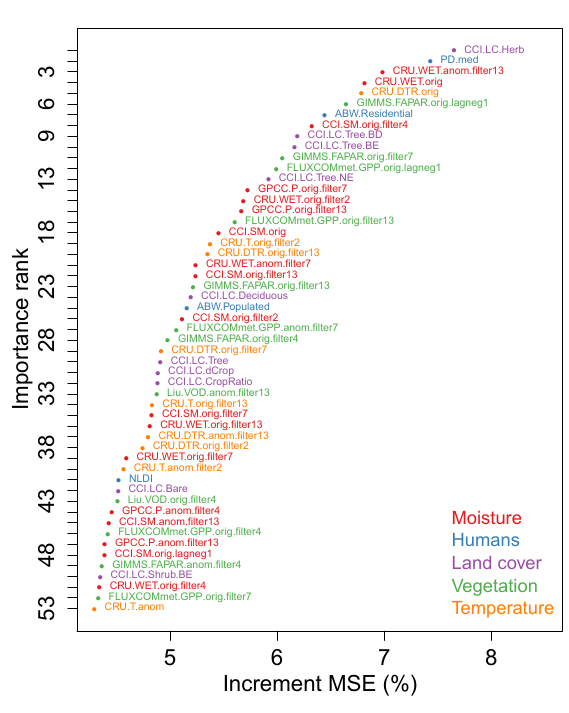
Figure A1. Importance of several predictor variables for predicting monthly burned area using a random forest. Importance is expressed as the percentage increment in mean squared error if a certain vari- able is not included in a random forest. Thus, the most important variables cause the largest increment in MSE. Variables that include “orig” or “anom” indicate original absolute values and anomalies (relative to the mean seasonal cycle), respectively. “filterX” indi- cates mean values over the X precedent months before the actual month for which burned area should be predicted. In total 132 vari- ables were included in this analysis, but variables below rank 53 are not shown in this